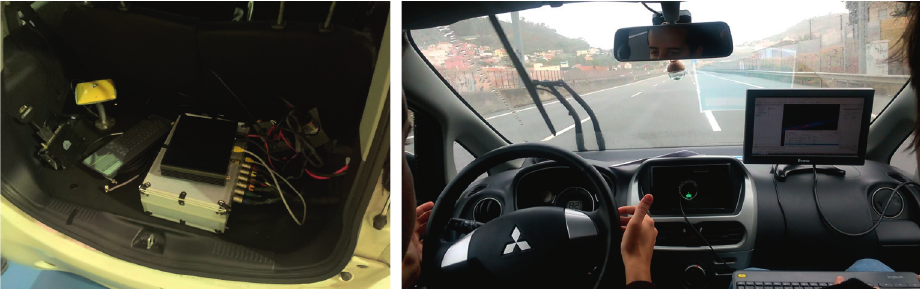
Figure 3: ODBII interface for controlling the vehicle and visualization of front and rear cameras for remotely controlling speed and